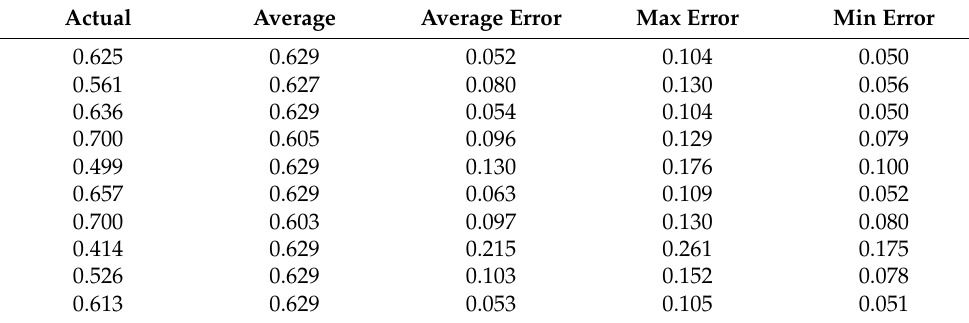
Table A126. Set 2, trials 31–40 data (actual PR value).